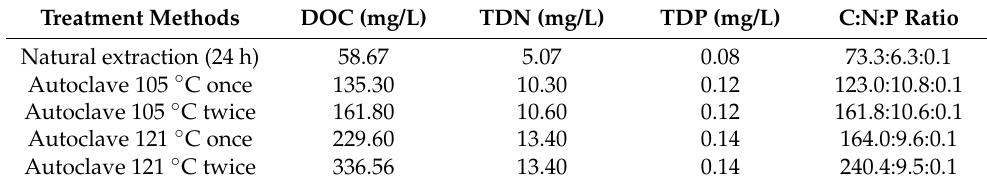
Table 3. Effect of different extraction methods on nutrient